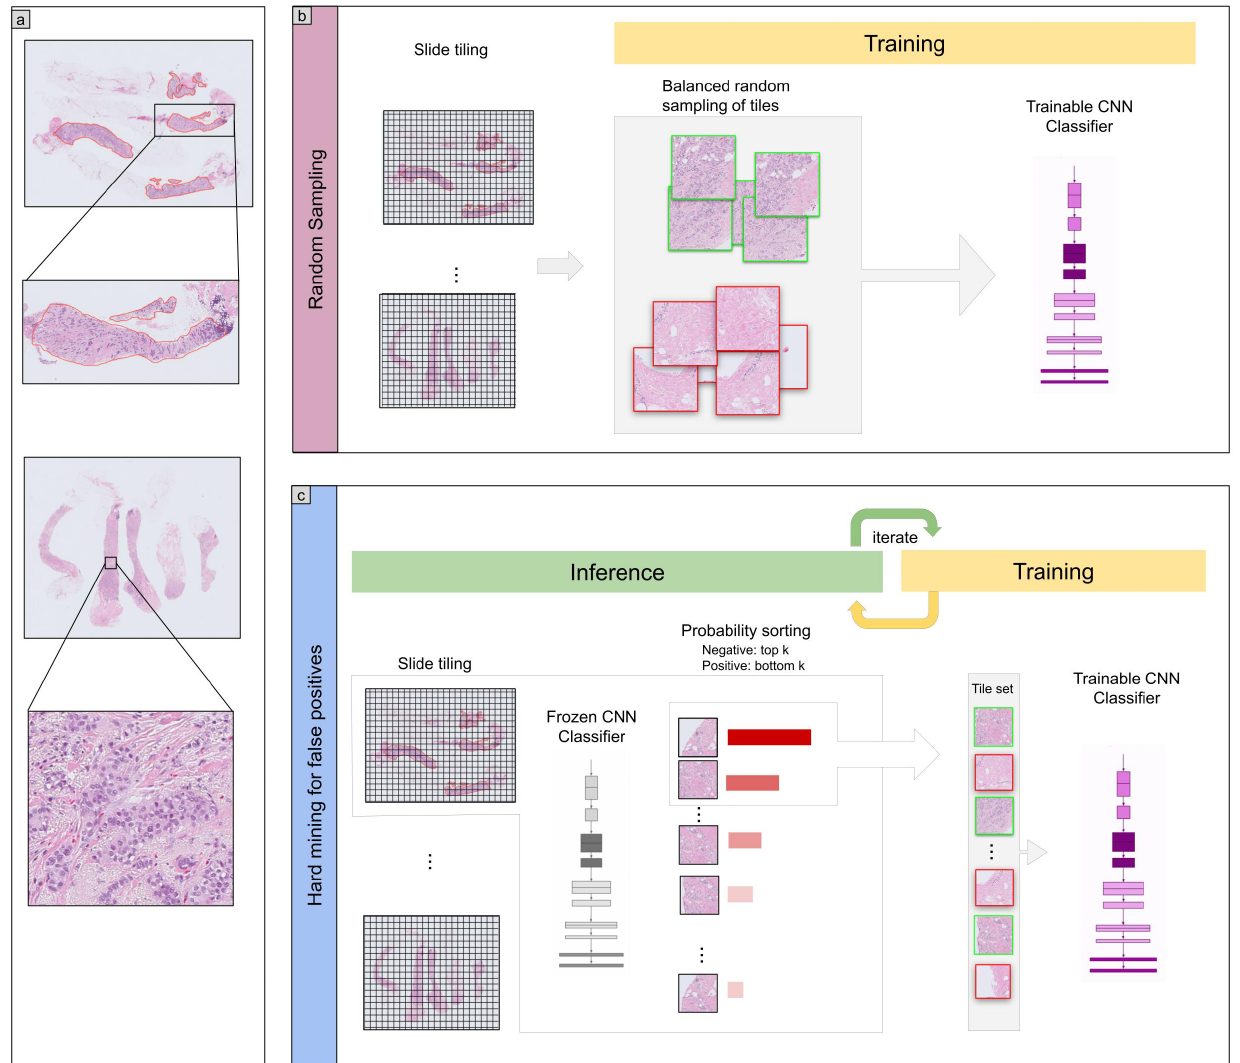
Figure 1. Overview. ( a ) shows and representative examples of WSIs with a zoom in on the tissue structure. Training consisted of two stages: random sampling and hard mining. In the first stage ( b ) we randomly sampled tiles from the positive and negative WSIs, restricting the sampling from WSIs that had annotations if they were positive. In the second stage ( c ) We iteratively alternated between inference and training, relying only on the WSI label. During inference, the model weights were frozen, and it was applied in a sliding window fashion on each WSI. The top k tiles with the highest probabilities were then selected from each WSI. During training the selected tiles were then used to train the